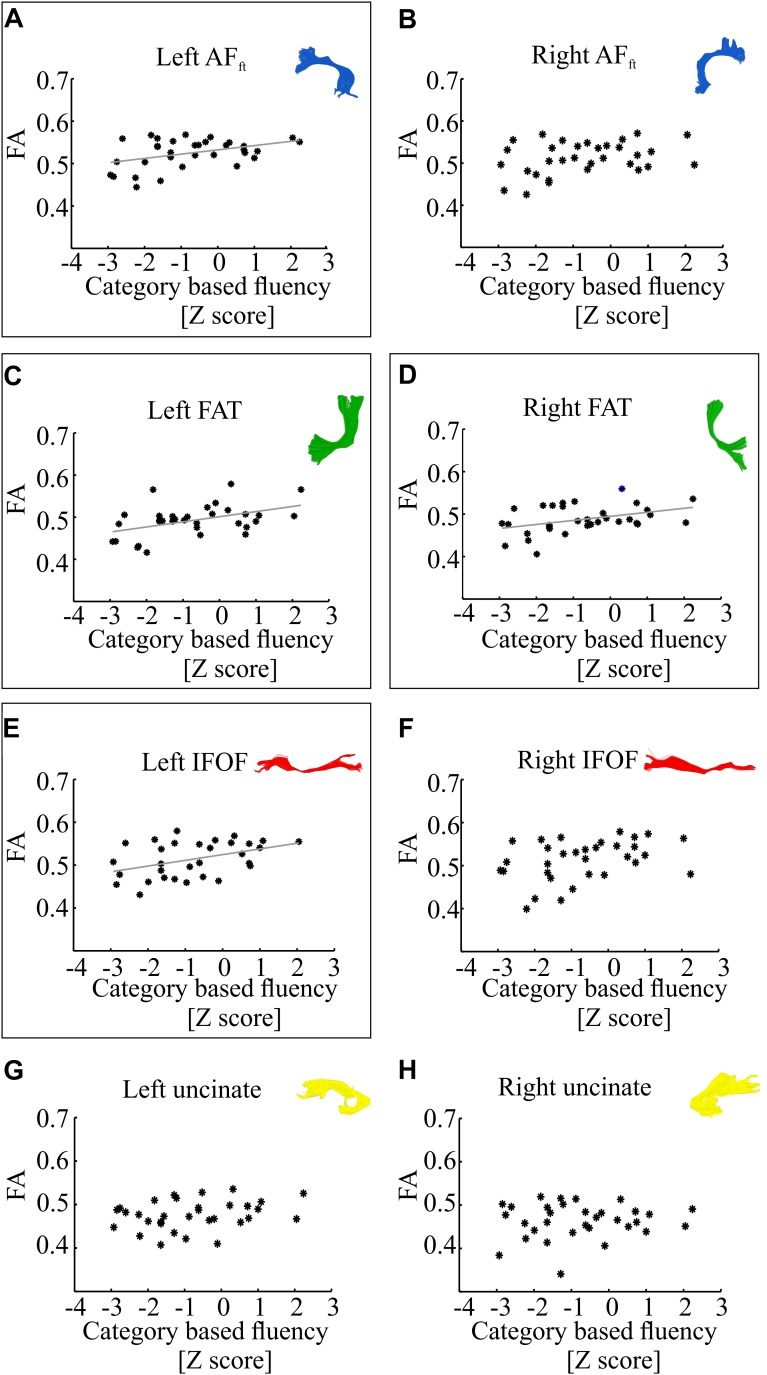
Correlations between category-based fluency and mean tract-FA. Mean tract-FA is plotted against age-standardized category-based fluency scores. Each dot represents an individual patient (N = 33). Each panel plots these values for a different tract: the left and right fronto-temporal arcuate fasciculus (AFft; A,B), frontal aslant tract (FAT; C,D), inferior fronto-occipital fasciculus (IFOF; E,F), and uncinate fasciculus (G,H). Significant Pearson correlations (after FDR correction for eight comparisons, q < 0.05) are framed with a rectangle. Significant correlations were detected in the left AFft (r = 0.42, p < 0.05), left and right FAT (r = 0.45, p < 0.01; r = 0.41, p < 0.05), left IFOF (r = 0.42, p < 0.05). Gray lines represent the best linear fits for the significant associations.